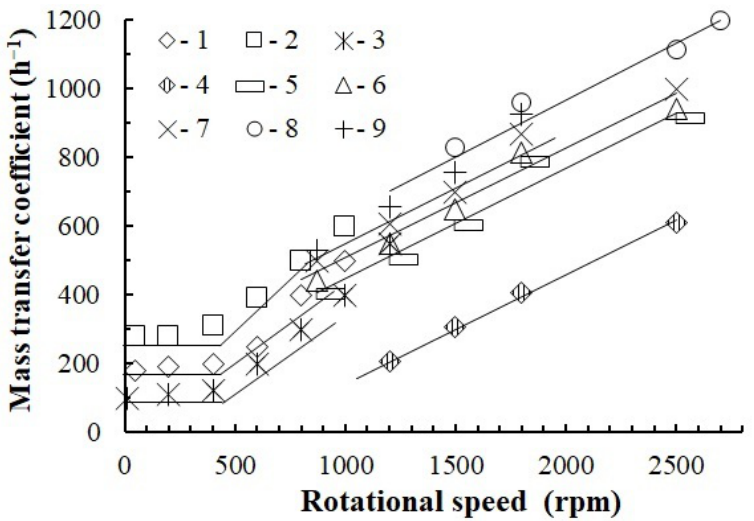
Figure 17. Mass transfer coefficient as a function of rotational speed of the stirrer. Experimental points (1–3) according to [49] stirrer with bubbler at D = 0.375 (m), H L / D = 1, d s = 0.11 (m): 1— u g = 0.018 (m/s); 2— u g = 0.03 (m/s); 3— u g = 0.04 (m/s); experimental points (4–9) data of the authors on intensive dispersion method at H L / D = 1.2, D = 0.28 (m), d s = 0.070 (m): 4—one partition, h = 0.05 (m); 5—one partition, h = 0.3 (m); 6—two partitions, h = 0.3 (m); 7—three partitions, h = 0.3 (m); 8—one partition, h = 0.3 (m), four paddles; 9—one partition, h = 0.3 (m), H L / D = 3.